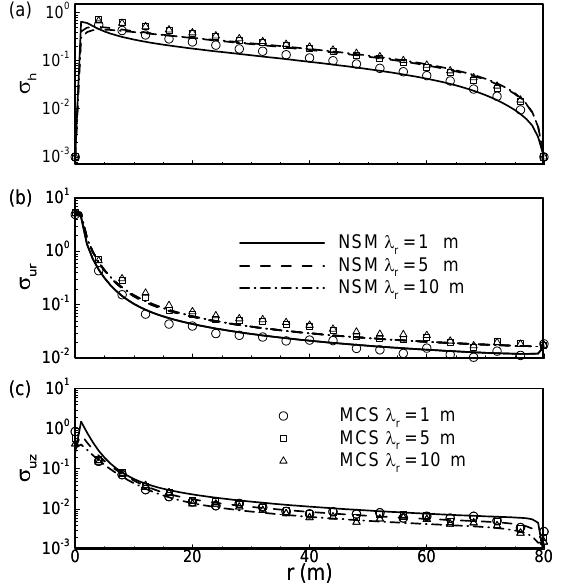
Fig. 7. The center line profiles of flow uncertainties that are obtained by using first-order NSM (lines) and MCS (symbols) at t= 80 day for fixed lnK variance of 0.5 and different r-direction correlation lengths.